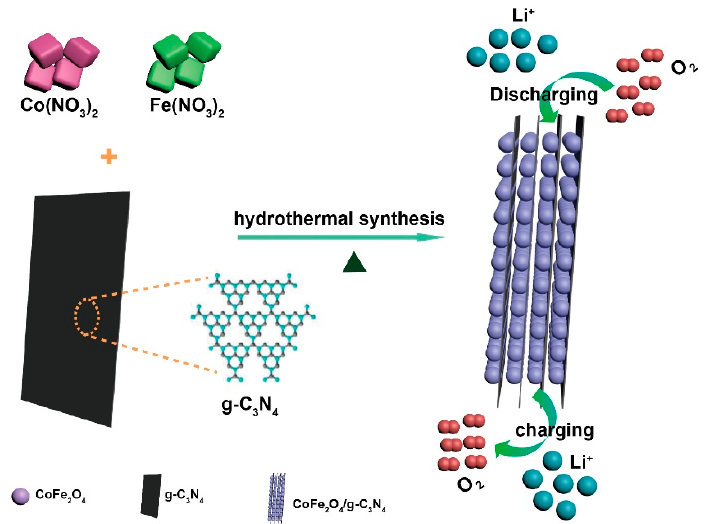
Scheme 1. Schematic illustration of the preparation of CoFe 2 O 4 /g-C 3 N 4 composite.